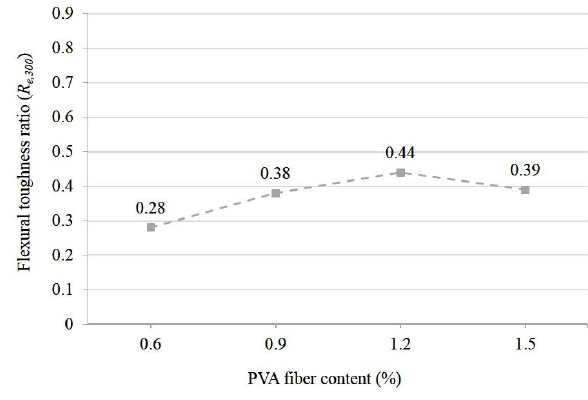
Figure 12: Flexural toughness ratio ( R e ,300 ) of NS composites with different PVA fiber